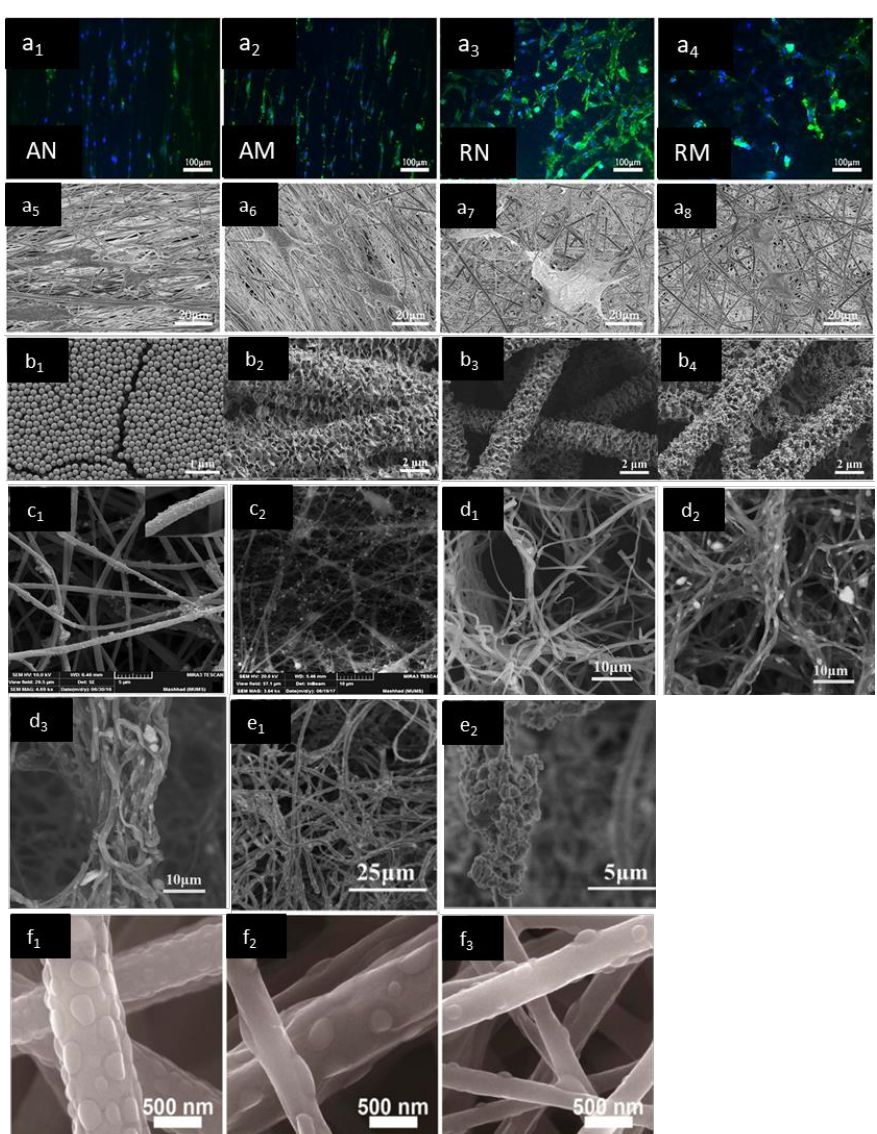
Figure 16. Effect of fiber alignment on the morphology of BMSCs on electrospun membranes ( a 1 – a 4 ) Immunofluorescence images of AN, AM, RN and RM. ( a 5 – a 8 ) SEM images of AN, AM, RN and RM, Reproduced with permission from [130] (License number: 5232540107019). SEM images of ( b 1 ) SiNPs, ( b 2 ) porous PLLA membrane after DOP surface modification and porous PLLA/DOP/SiNP membranes with different SiNP concentrations ( b 3 = 0.05, b 4 = 0.10) Reproduced with permission from [132] (License number: 5232550661164), SEM image of ( c 1 ) nanoHA- coated nanofibers, ( c 2 ) liposome-loaded scaffolds (liposcaffolds), Reproduced with permission from [133] (License number: 5232550143142). SEM images of the internal morphological structures of ( d 1 ) PLA/GEL, ( d 2 ) nHA/PLA/GEL, and ( d 3 ) nHA/PLA/GEL-PEP 3D nanofibrous scaffolds, respectively, Reproduced with permission from [134] (License number: 5232541047315). SEM images of surface morphology of the P3C1 scaffolds after biomineralization for ( e 1 ) 7 days, ( e 2 ) SEM image of mineral clusters after 7 days mineralization in SBF with high magnification, reproduced with permission from [140] (License number: 5232551100684). SEM images of electrospun fibers prepared at different temperatures ( f 1 = 35 ◦ C), ( f 2 = 50 ◦ C), ( f 3 = 60 ◦ C) using a PLA/CS 70:30 weight ratio; Reprinted (adapted) with permission from [141]. Copyright (2022) American Chemical